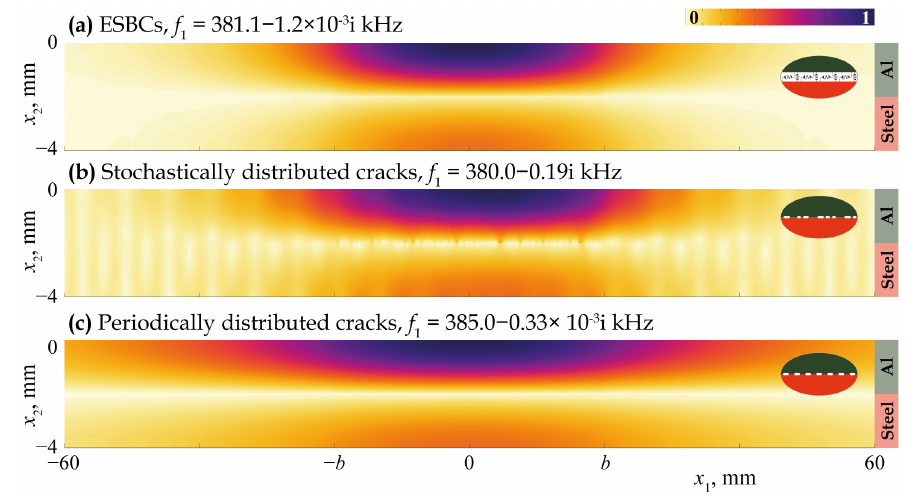
Figure 11. Eigenforms | u | ( x 1 , x 2 ) related to eigenfrequencies f 1 for a uniform partially closed delami- nation of length w = 40 mm with the crack density C = 0.5 modelled as an array of stochastically ( b ) and periodically ( c ) distributed cracks and via the ESBCs ( a ).